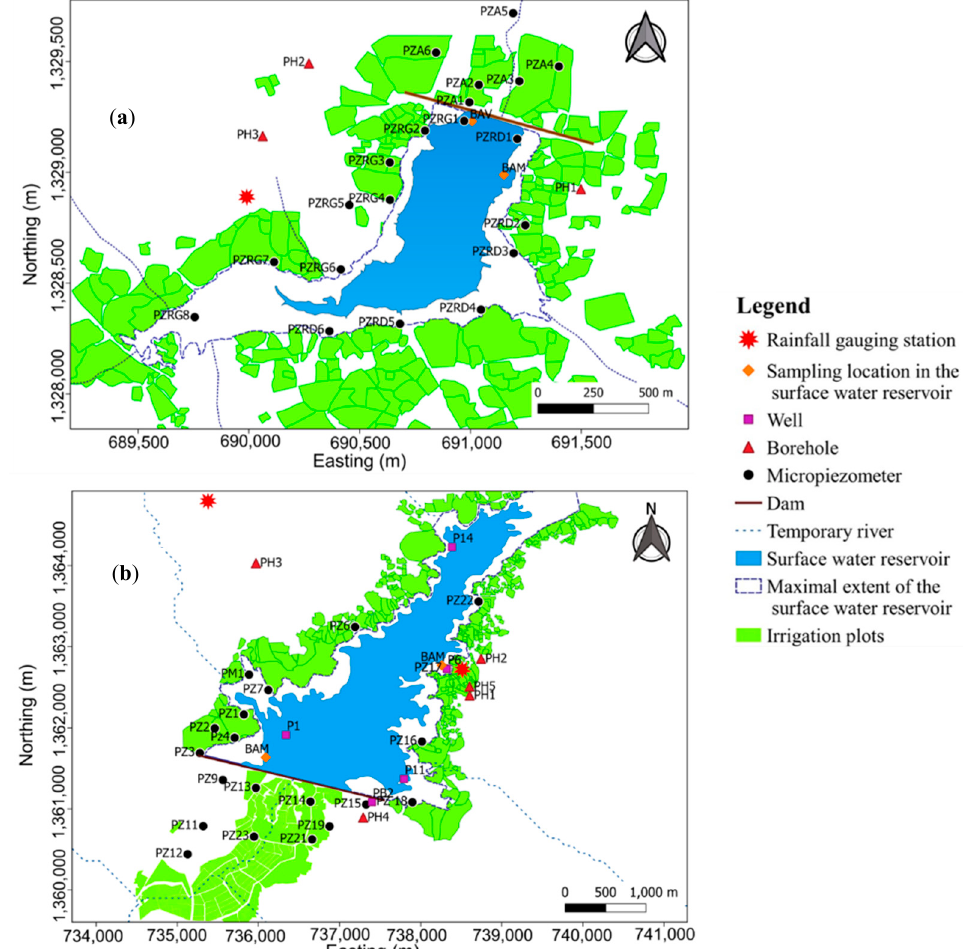
Figure 5. Location of micropiezometers (Pz), rainfall gauging station, and sample sites within Kierma ( a ) and Mogtédo ( b ) watersheds.